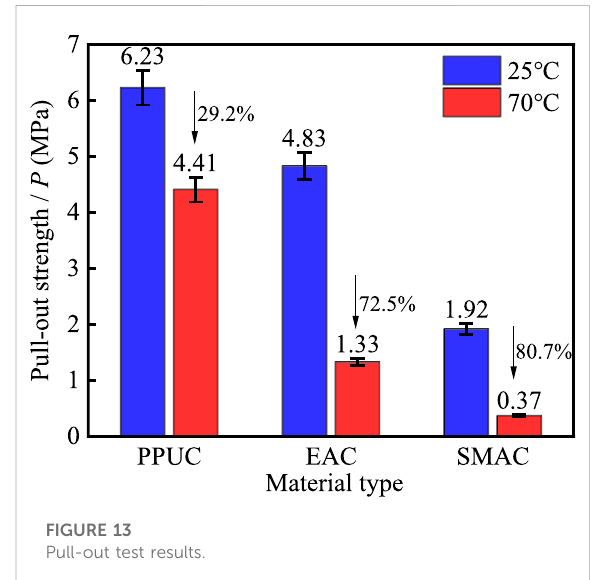
FIGURE 13 Pull-out test results.